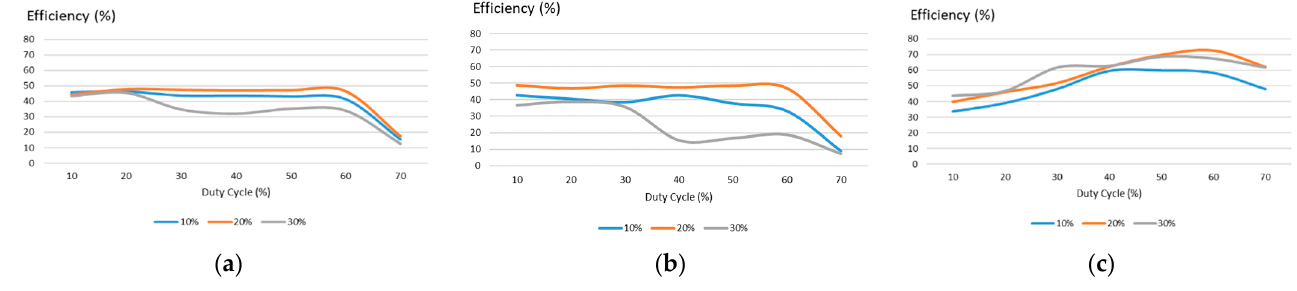
Figure 6. Overall power-to-hydrogen efficiency for: ( a ) T = 15 °C; ( b ) T = 20 °C; and ( c ) T = 25 °C.